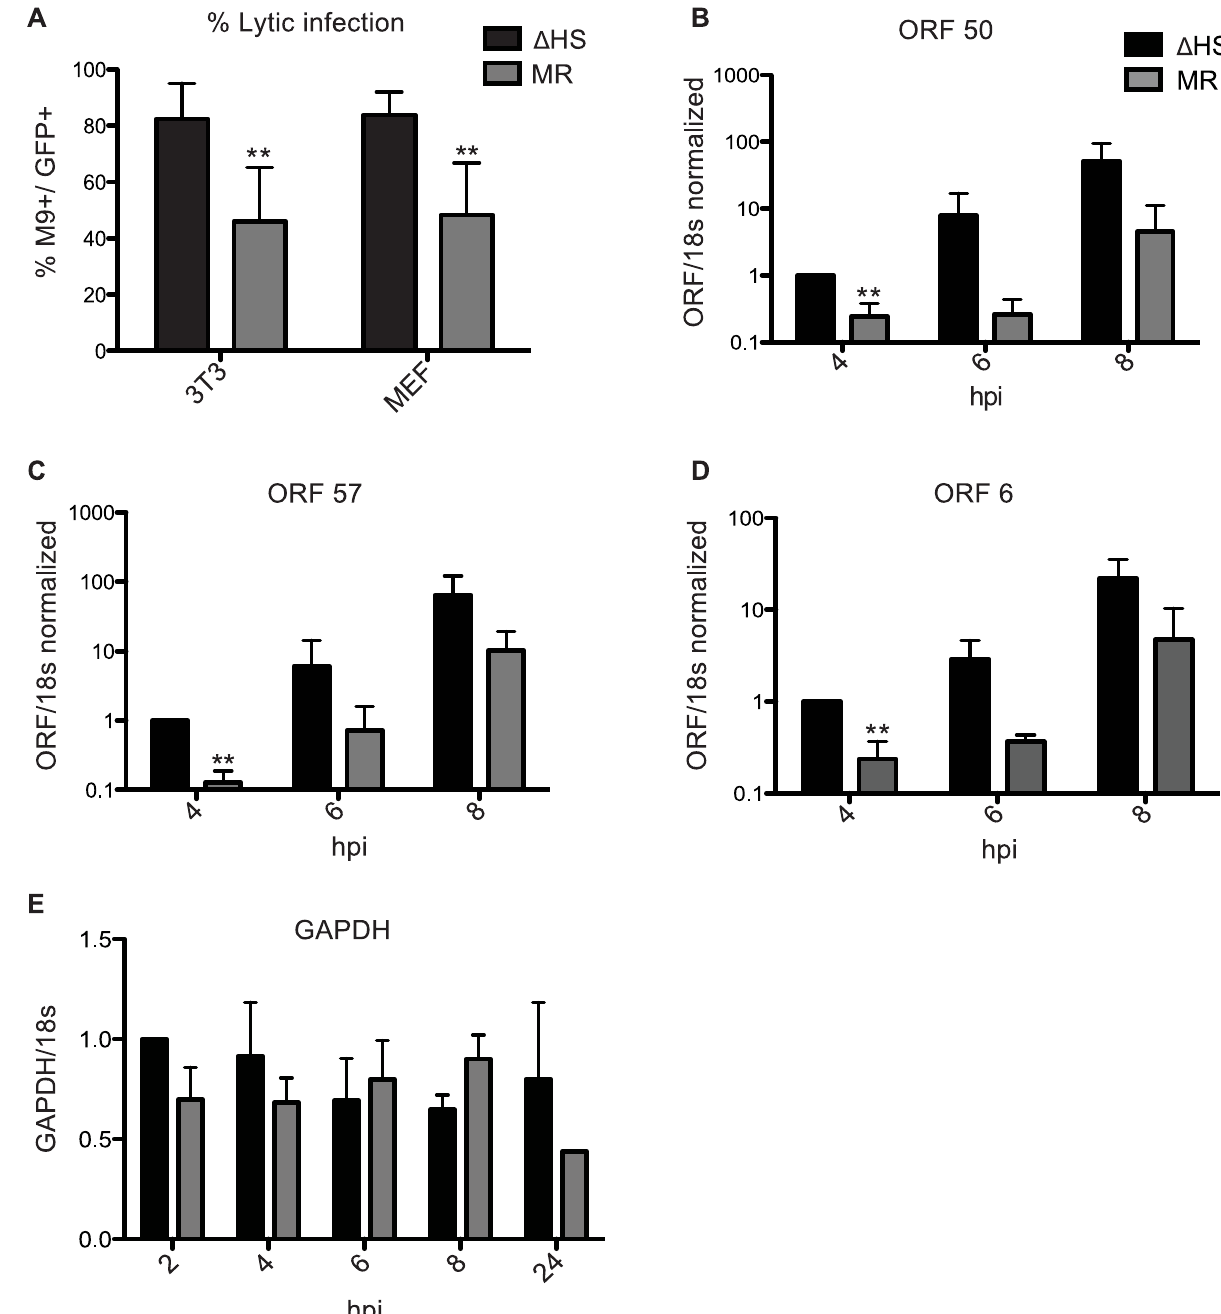
Figure 5. Failure to degrade viral mRNAs leads to enhanced lytic cycle entry. (A) Shown is the percent of lytic-expressing infected NIH 3T3 or MEF cells. Cells were infected at an MOI of 5 with GFP-BAC MHV68 MR or D HS and were analyzed at 18 hpi for GFP and M9 expression by immunofluorescence using anti-M9 antibodies. 5 fields of view from three independent experiments were counted and the percentage of GFP + M9 + cells calculated. ** Indicates p-value , 0.01, determined by student t-test. (B–D) To measure levels of RTA-responsive transcripts after infection with MR or D HS MHV68, NIH 3T3 cells were infected at an MOI of 5 and RNA harvested at indicated times post infection. RT-qPCR was used to quantify relative levels of ORF 50 (B), ORF 57 (C), and ORF 6 (D). (E) GAPDH levels were measured to show that host shutoff had not yet initiated at the 8 hpi time point. expected, decreased at 24 hpi during host shutoff (Figure 5E), compared to the MR virus. A similar trend was observed at 6 and 8 hpi, although the differences at these time points were not which generally starts 10–18 hpi [15]. This confirmed that the statistically significant. Importantly, the levels of the cellular effects on viral transcript accumulation manifested prior to the GAPDH mRNA remained unchanged between 2–8 hpi but, as onset of muSOX-induced mRNA degradation, and therefore must